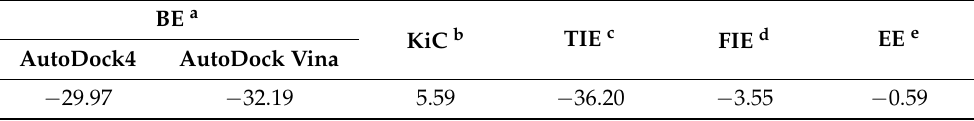
Table 3. Calculated parameters (a–e) of docked Dex with 6LU7